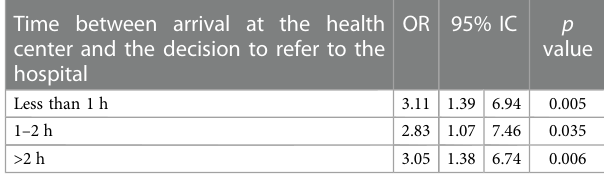
TABLE 3 Association between decision-making time to consult and intrapartum stillbirth. Time between the decision to seek care and arrival at the heath center CSPS